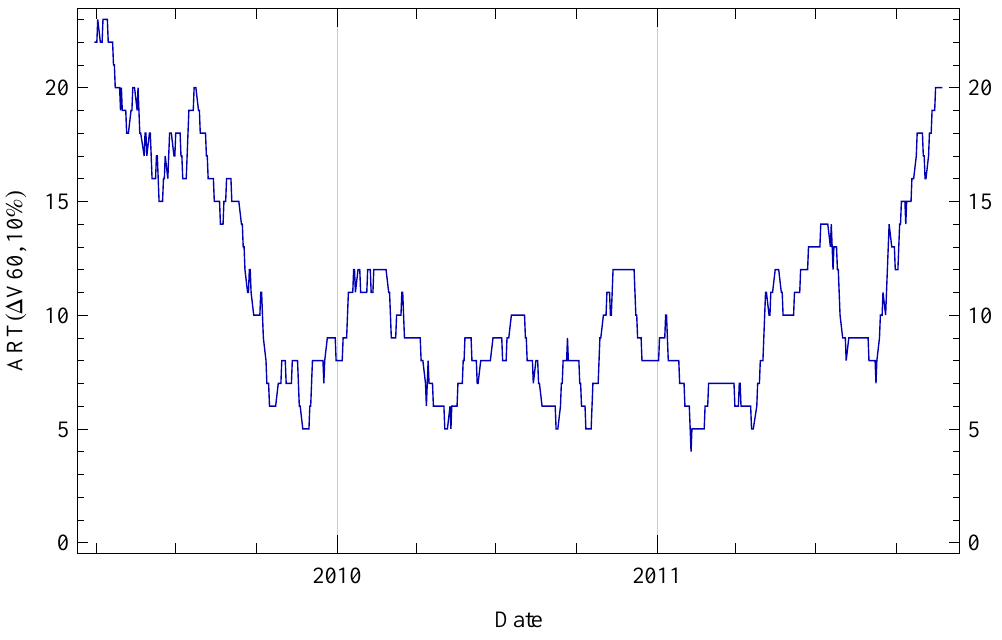
Figure 3. Evolution of the ART ( ∆ V60 , 10% ) integer-valued function over time for INTC. The scoring function computes a score for each stock: for each day in the snapshot aggregation approach and for a range of days in the Dynamis aggregation. The scoring function employs a weight vector (user preferences) in the snapshot aggregation approach and a weight vector, as well as a threshold vector in the Dynamis aggregation